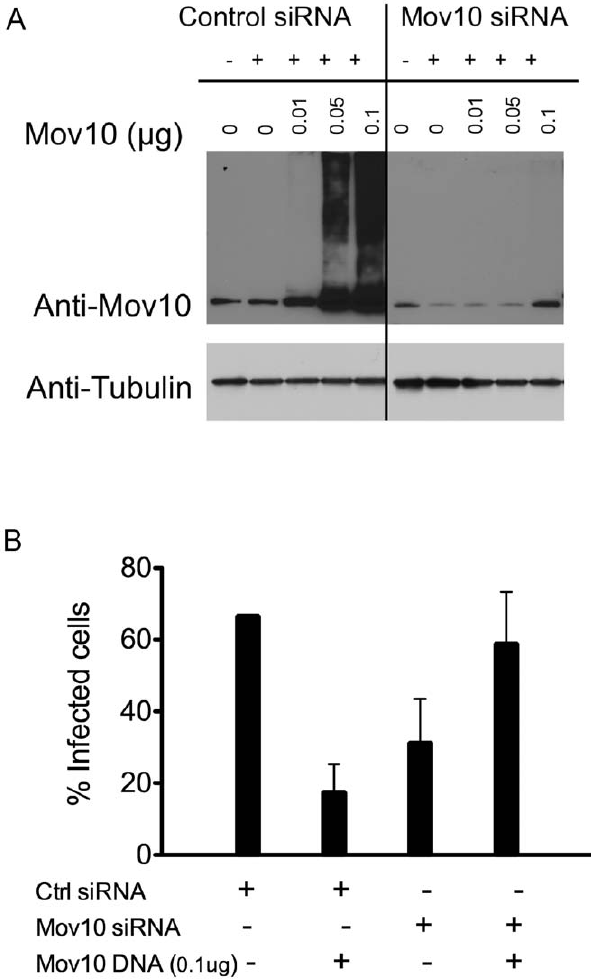
Figure 5. An optimal concentration of Mov10 is required for HIV-1 infectivity. 293T cells were transfected with a non-targeting siRNA or Mov10-specific siRNA. At 48 h post-siRNA transfection, the cells were transfected with 1.5 m g of pHIV-RFP, 0.7 m g of p-L-VSV-G and increasing amounts of the Mov10 expression plasmid. At 96 h post-siRNA transfection: ( A ) the cell lysates were examined by Western blot for Mov10 levels using an anti-Mov10 antibody. Equal protein loading was confirmed by probing with anti-tubulin antibody. ( B ) After normalizing for p24 values, virus obtained from the transfections was used to infect HeLa cells and infectivity was measured by FACS. The % infected cells represents the percentage of RFP-positive cells in the cell population. Error bars represent one standard deviation.